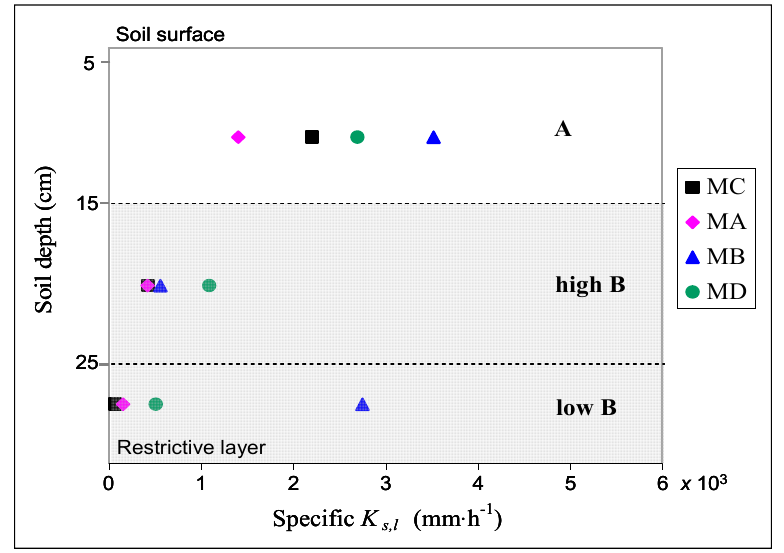
Figure 4. Computed specific K s,l values in the A horizon and in the upper and lower layers of the B horizon. The shaded area is the soil B horizon.